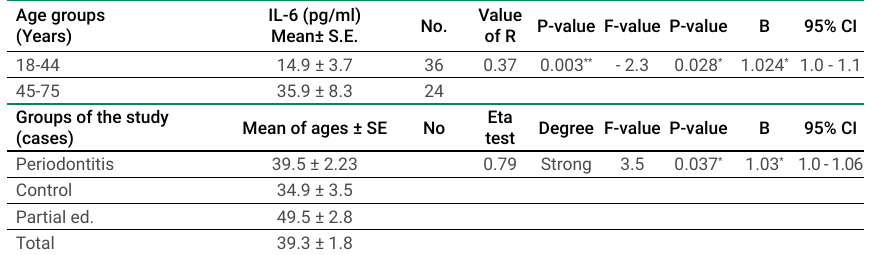
Table 2. Relation and differences of ages with salivary (IL-6) and cases Age groups (Years)